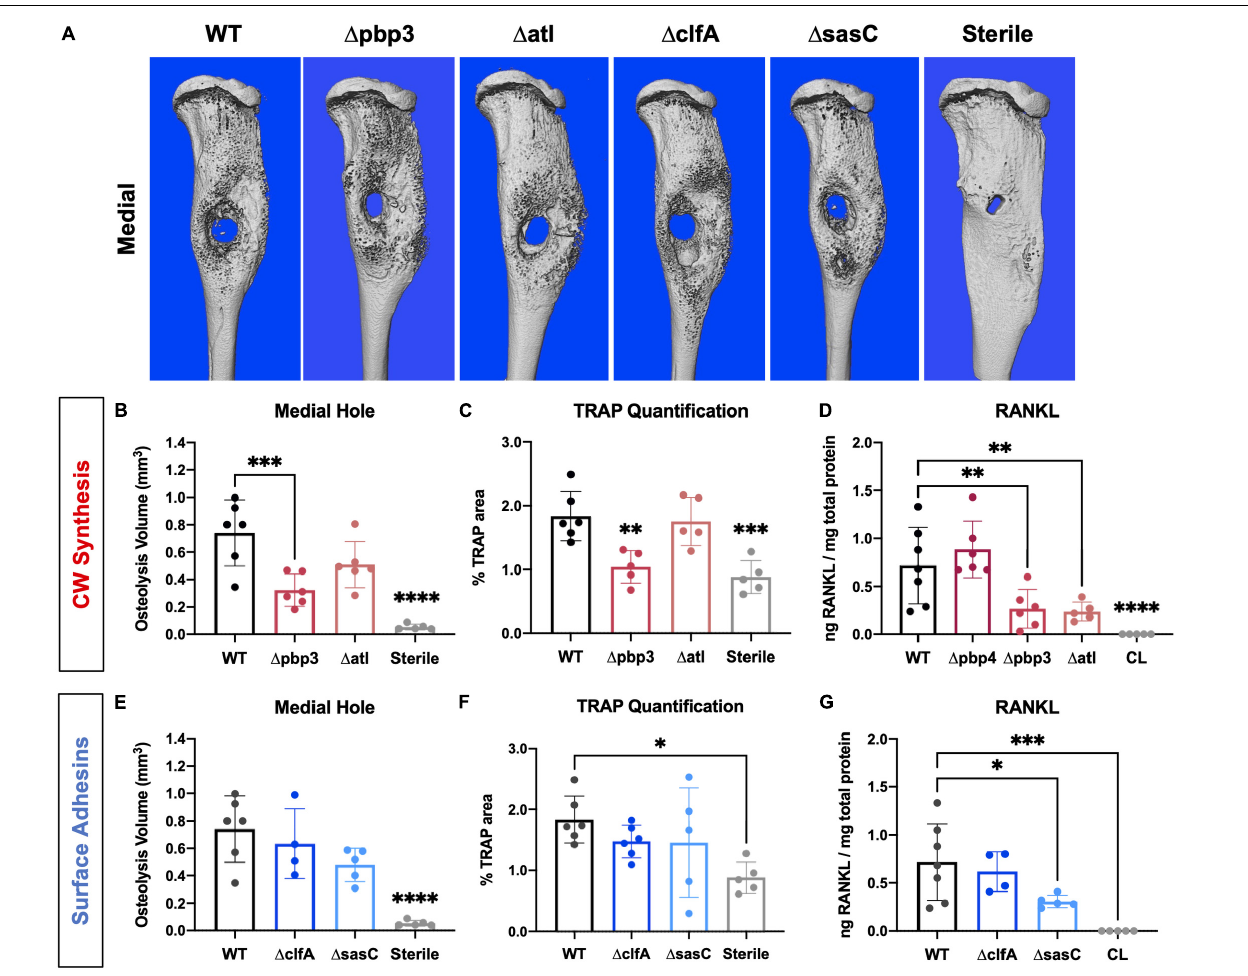
FIGURE 7 | Staphylococcus aureus cell wall biosynthesis mutations reduce osteoclast-mediated peri-implant osteolysis compared to WT, and surface adhesin mutations do not change bone loss. Sterile or S. aureus -infected tibiae were harvested on day 14 postinfection for micro-computed tomography ( µ CT) analyses. The µ CT DICOM scans were reconstructed using Amira TM , and medial hole volume was identified though the depth of the tibial cortex by manual segmentation and interpolated between slices. Representative 3D reconstructions of the µ CT scans for all infection and sterile pin groups are shown from the medial side ( A ; n = 5–6). Medial hole volumes for each tibia are presented with mean ± SD for each group ( B , C,E , F ; n = 5–6). Pbp3 deletion resulted in less osteolysis of the medial cortex (B) , similar to pbp4 deletion shown in previous work (Masters et al., 2020). ClfA and sasC deletion did not change peri-implant osteolysis of the medial tibial cortex (E) . Histologic sections from sterile and infected tibiae were stained for TRAP expression to measure osteoclast prevalence. % TRAP-stained area was quantified using Visiopharm and showed a significant reduction in % TRAP staining in (cid:49) pbp4- and (cid:49) pbp3-infected tibiae and not (cid:49) clfA and (cid:49) sasC ( C , F ; n = 5–6 presented as mean ± SD). Local concentrations of RANKL were quantified for each infection genotype as well as within contralateral (CL) limbs of WT S. aureus- infected animals by measuring via ELISA of bone tissue homogenate (D,G) . Significance was evaluated by one-way ANOVA with Dunnett’s post-hoc for multiple comparisons vs. WT, ∗ p < 0.05, ∗∗ p < 0.01, ∗∗∗ p < 0.001, ∗∗∗∗ p <